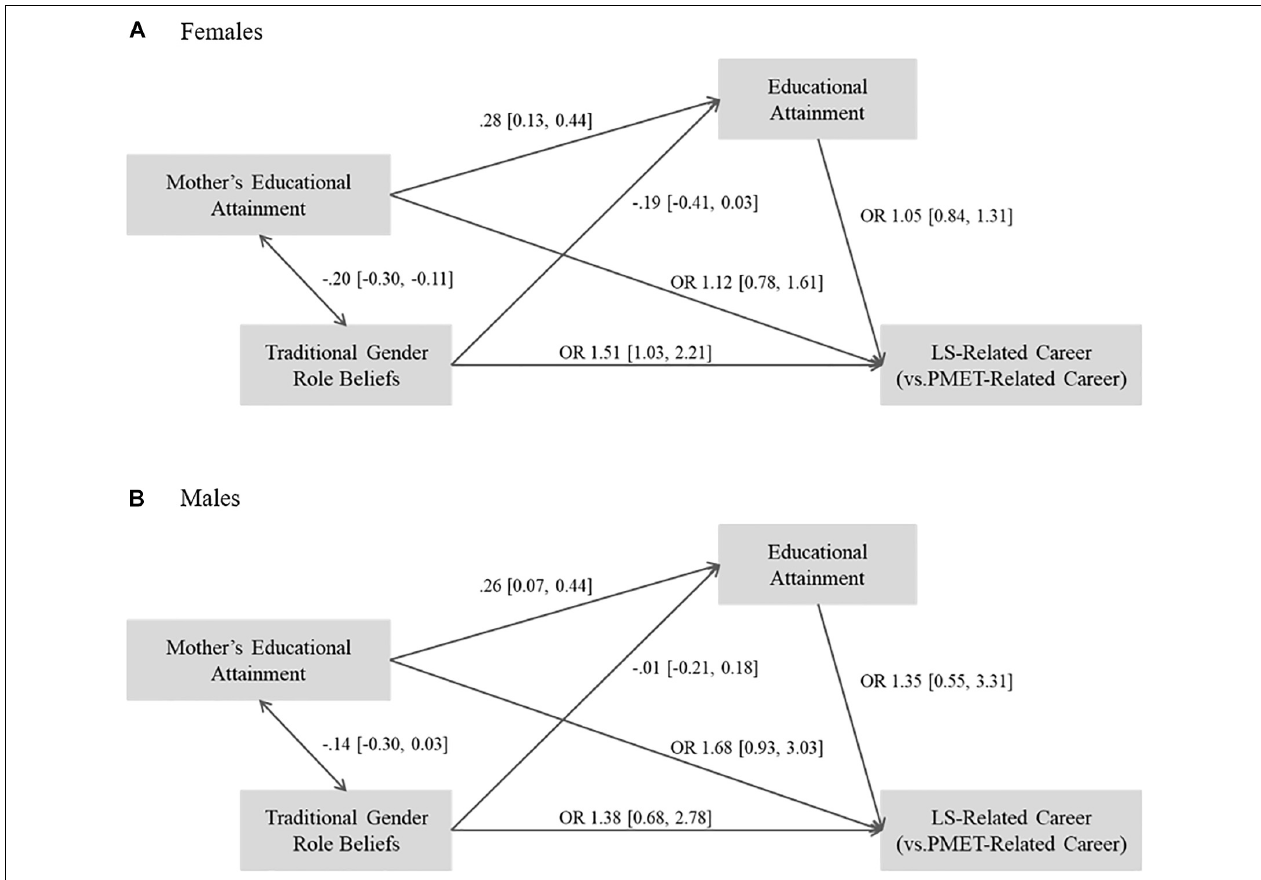
FIGURE 4 | Results of multi-group path analyses by gender for LS-related careers vs. PMET-related careers. (A) Results for females and (B) results for males. Standardized coefficients are shown for continuous variables. OR, Odds Ratio. 95% Confidence intervals in brackets. Confidence intervals excluding 0/1 for regression coefficients/odds ratios indicate statistical